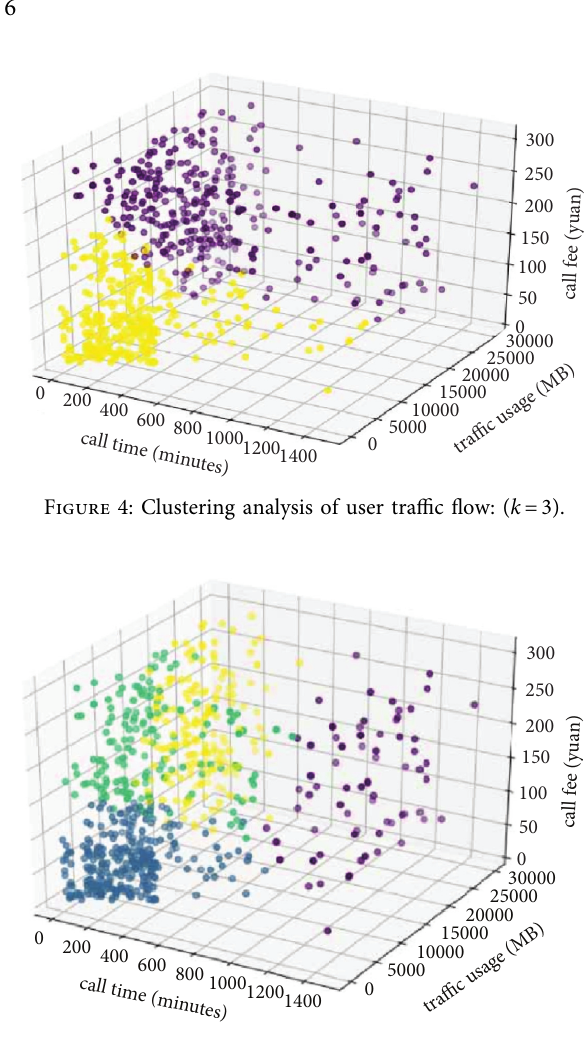
Figure 5: Clustering analysis of user traffic flow: ( k � 3).